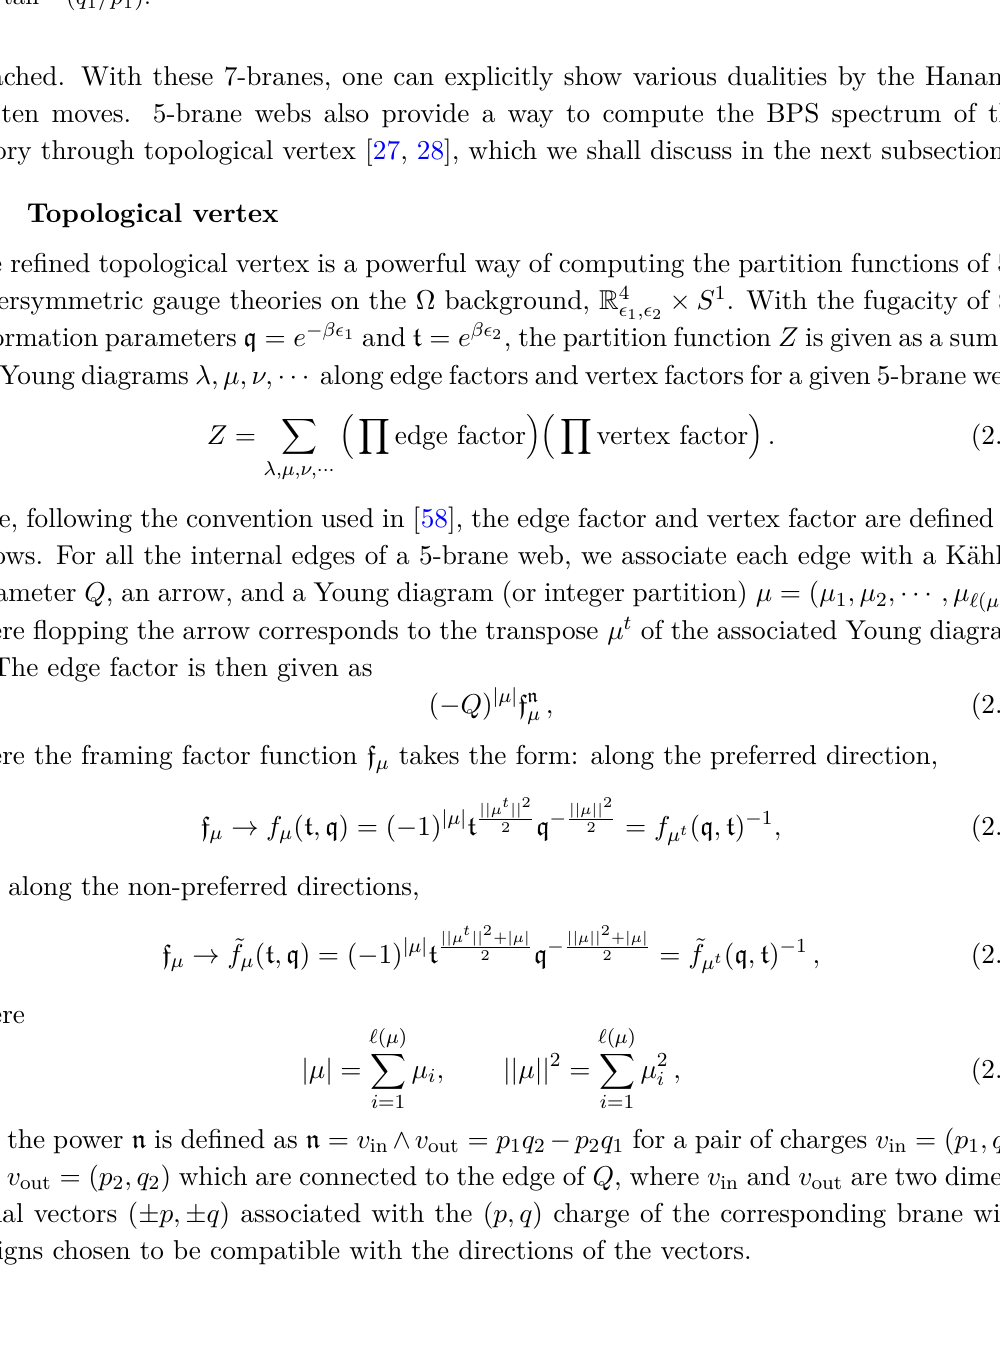
Table 1 . Worldvolume configuration of 5-brane webs. The occupation of each brane is marked with × or ϑ , where a ( p 1 , q 1 ) 5-brane appears as a line on the ( p, q ) -plane with the slope given by ϑ = tan − 1 ( q 1 /p 1 )